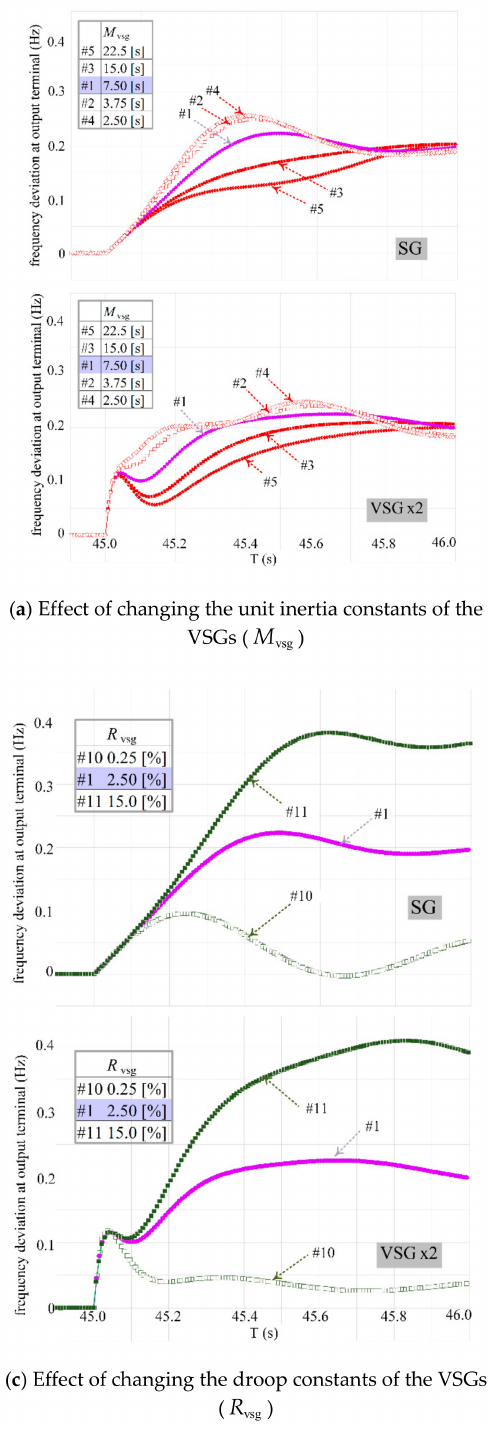
Figure 8. Comparison of the frequency deviations at the output terminal. (Note the sign